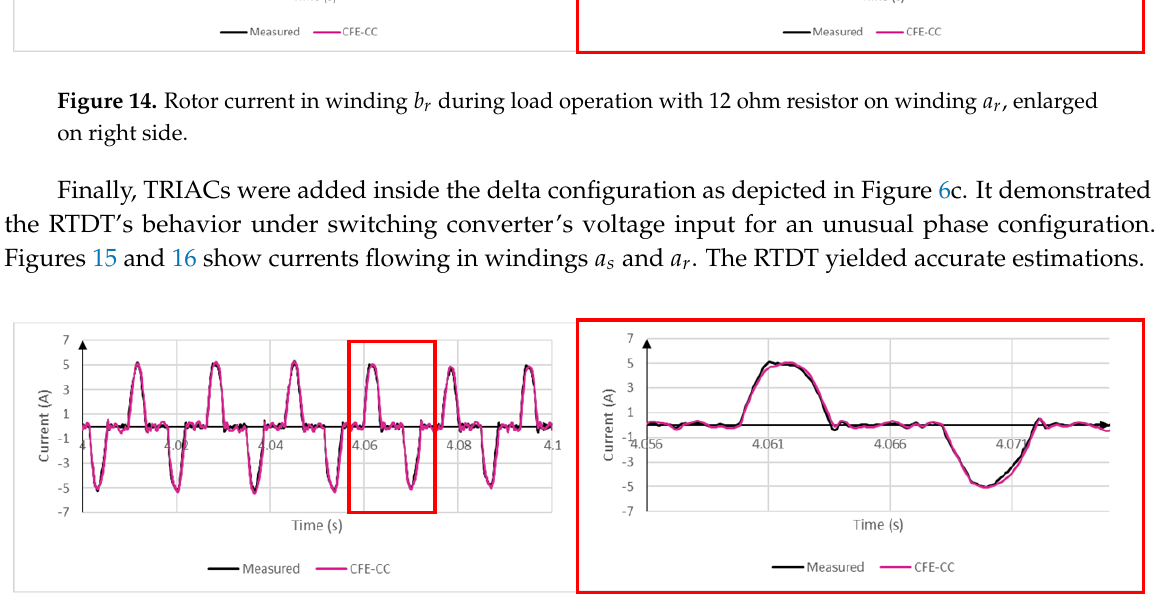
Figure 15. Stator current in winding a s during load operation and fed through TRIACs, enlarged on right